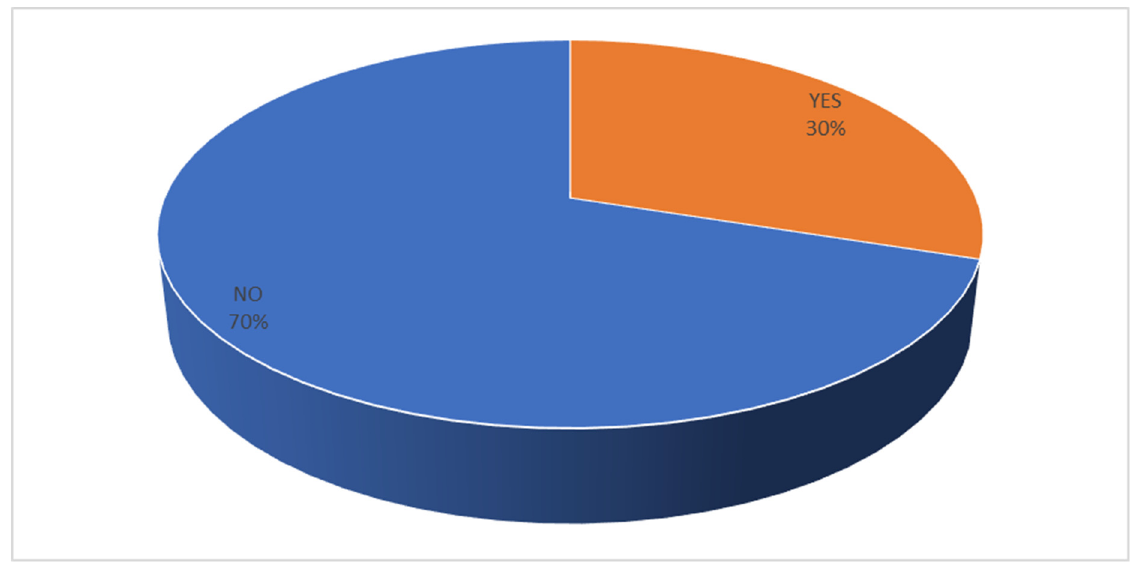
Figure 2. Response (%) of participants on the need to combine African ginger with other medicinal plants for managing health conditions in humans.